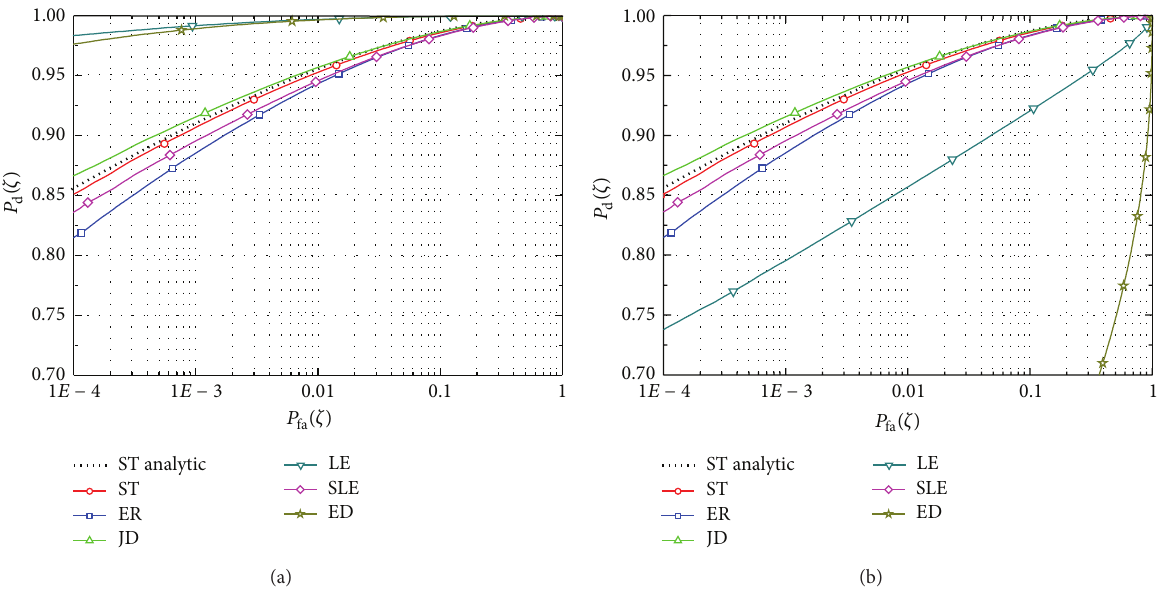
Figure 13: ROCs over a Rayleigh fading channel, for 𝐾 = 4, 𝑁 = 200, 𝑃 = 3, SNR 1 = − 1dB, SNR 2 = − 3dB, and SNR 3 = − 10dB, with 𝜇 = 0 dB (a) and 𝜇 = 0 . 5 dB (b) for the LE and the ED.